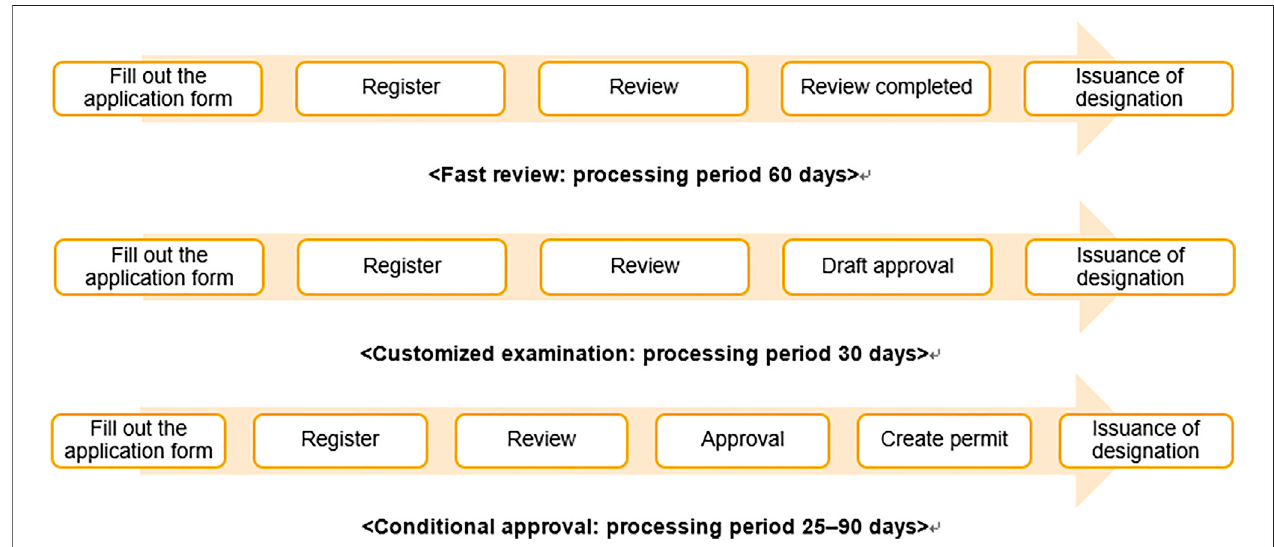
FIGURE 1 | Procedures and timeline for rapid processing of RMs. Note: The processing procedures for designating advanced biopharmaceuticals as subject to rapid processing, for customized screening of advanced bio-medicine, and for conditional manufacturing and sales item approval.